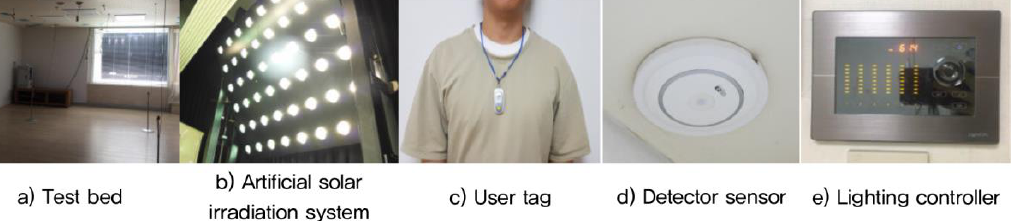
Figure 3. Overview of test bed and measurement apparatus.